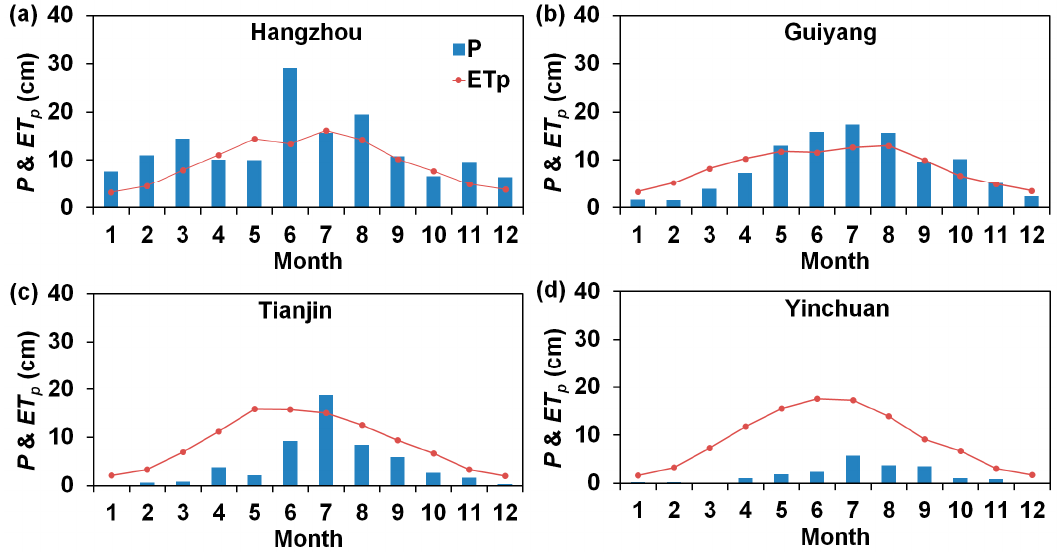
Figure 1. Mean monthly precipitation ( P ) and potential evapotranspiration ( ET p ) during the study period at ( a ) Hangzhou, ( b ) Guiyang, ( c ) Tianjin, and ( d ) Yinchuan.